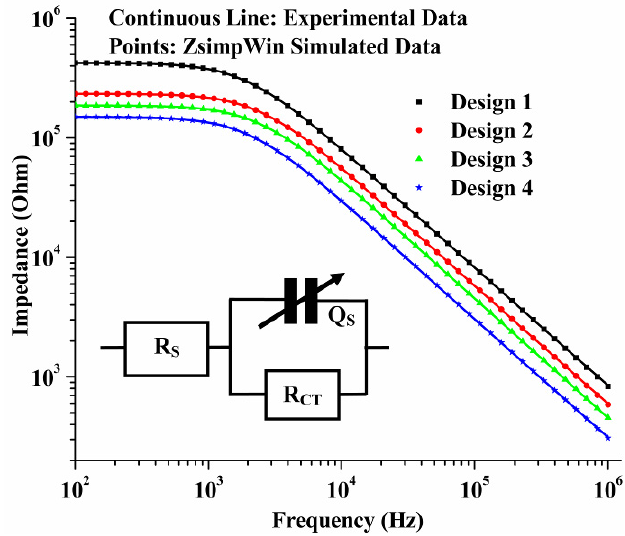
Fig. 3: Bode Plot of PBS with its equivalent circuit. Impedance of blood